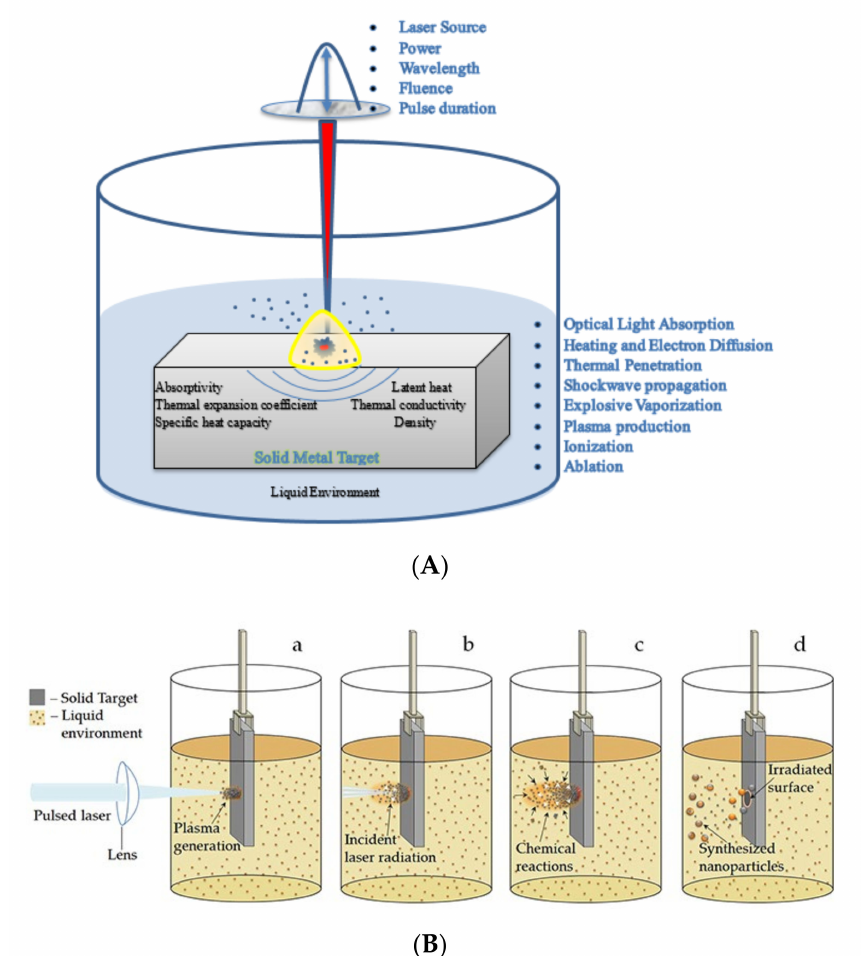
Figure 3. ( A ) Illustration of pulsed laser ablation in liquid technique showing the parametric influence of laser input parameters, bulk material properties, and sequential events leading to ablation. ( B ) Stages of pulsed laser ablation in liquid. Adapted with permission from Ref. [74]. Copyright 2016,